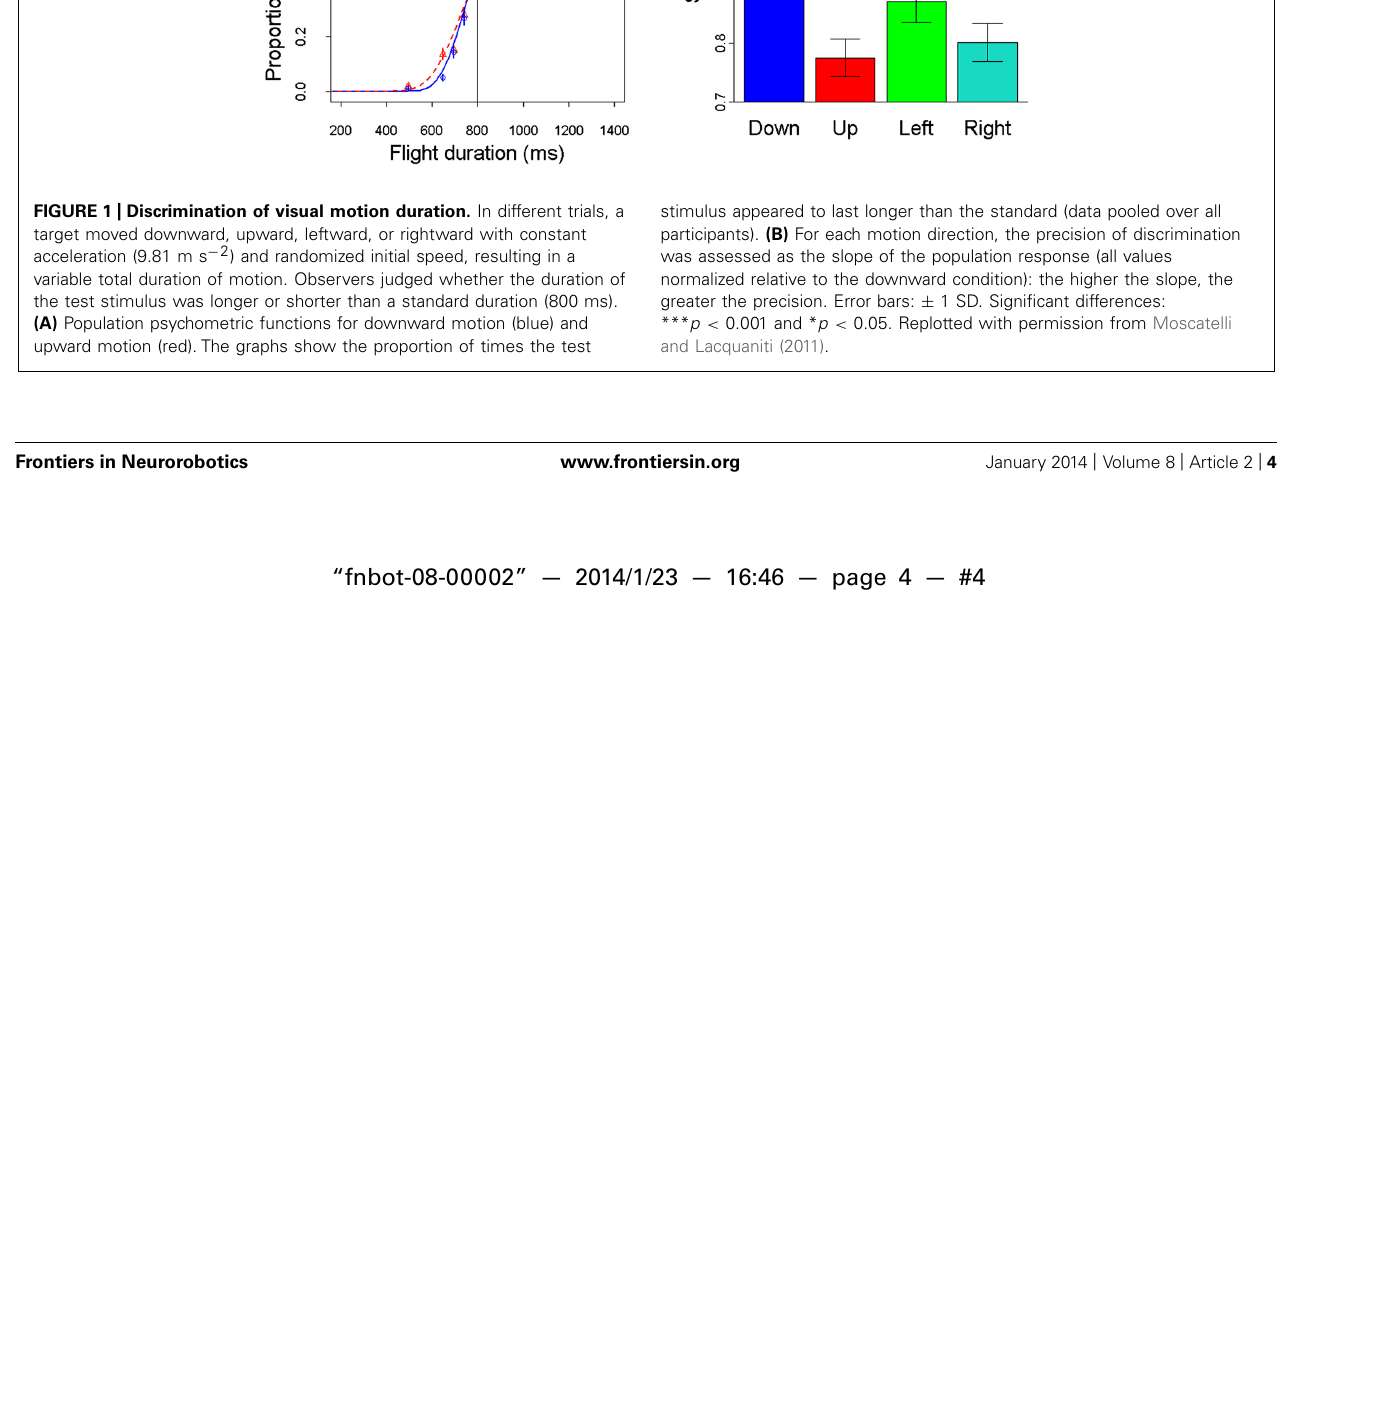
FIGURE 1 | Discrimination of visual motion duration. In different trials, a target moved downward, upward, leftward, or rightward with constant acceleration (9.81 m s − 2 ) and randomized initial speed, resulting in a variable total duration of motion. Observers judged whether the duration of the test stimulus was longer or shorter than a standard duration (800 ms). (A) Population psychometric functions for downward motion (blue) and upward motion (red). The graphs show the proportion of times the test